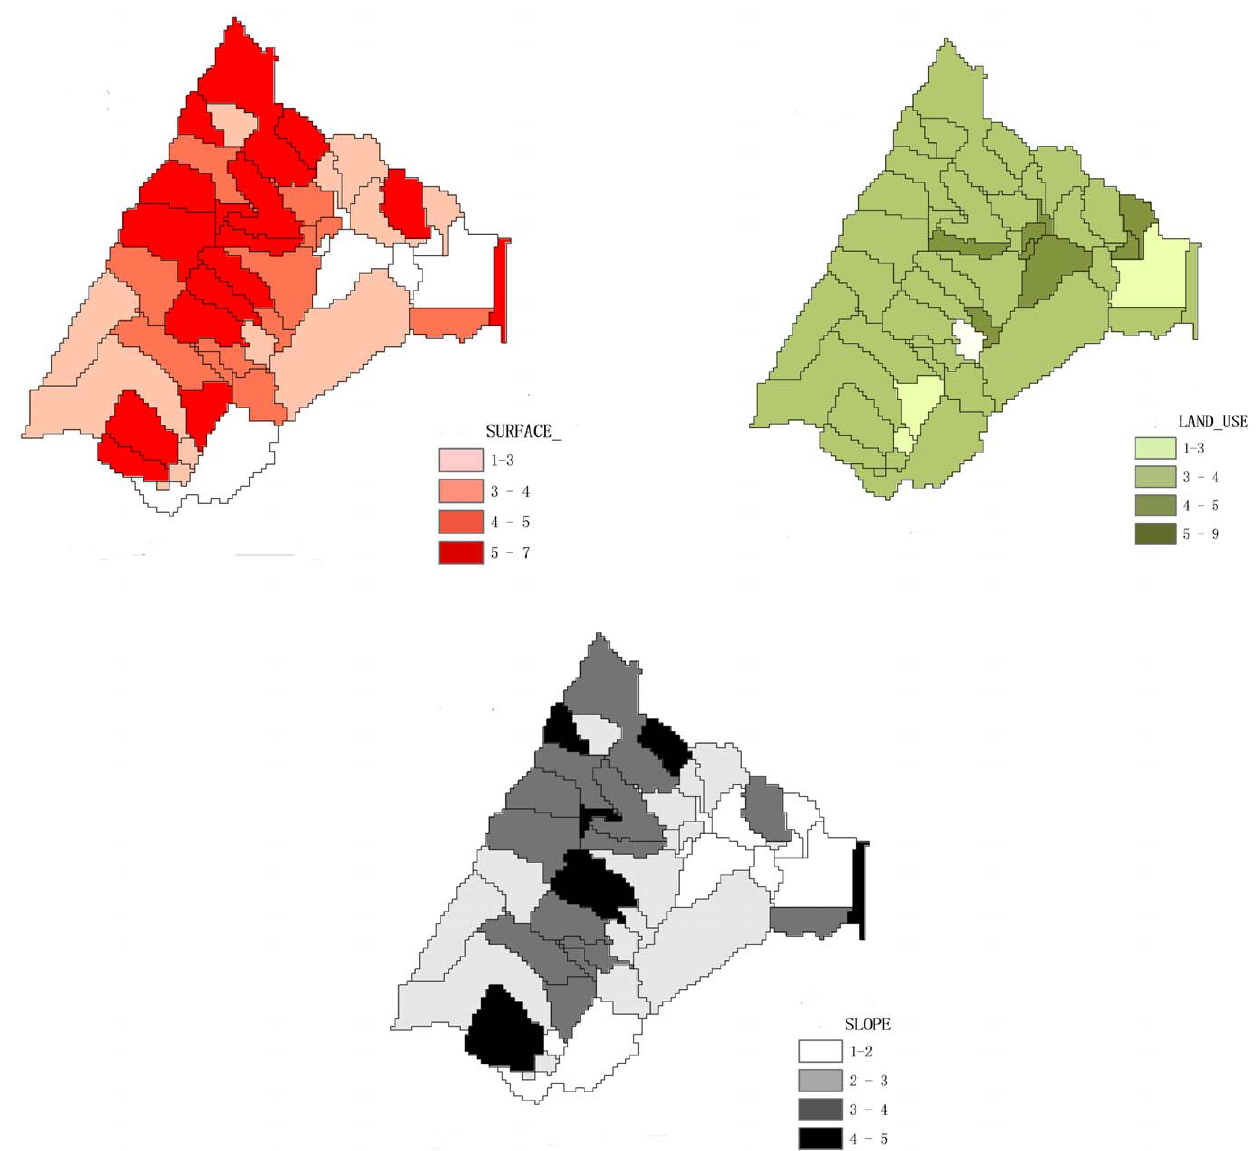
Figure 4. The spatial distribution of the quantified information for surface status, land use and slope.